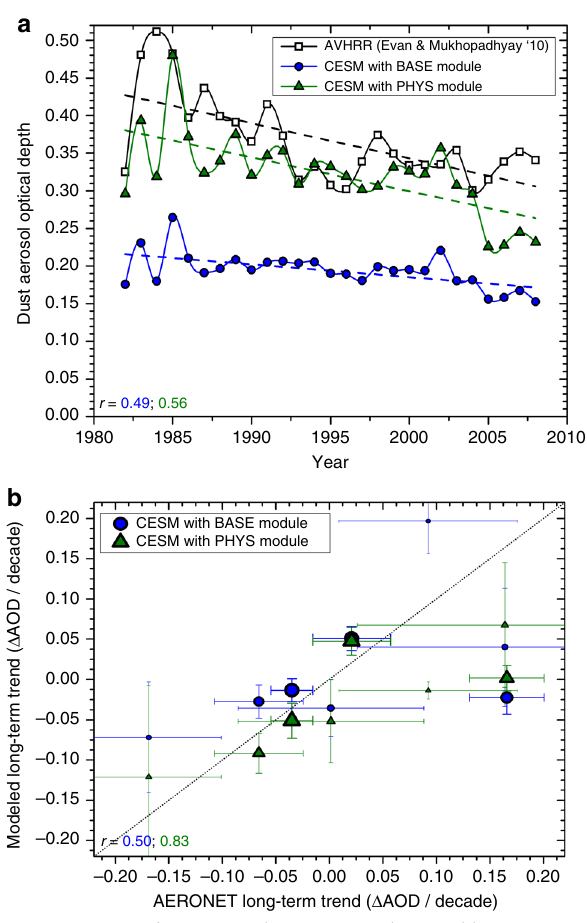
Fig. 1 Comparison of CESM simulations against historical long-term changes in dust aerosol optical depth. a Shown is the AVHRR satellite record of annually averaged dust AOD (black line and squares) over the dust-dominated region of 10 – 20°N and 20 – 30°W, off the West-African coast 27,32 . The CESM simulation with the BASE dust emission module (blue line and circles) poorly reproduces the magnitude and historical trend of the dust AOD, whereas CESM with the PHYS emission module (green line and triangles) better reproduces both the magnitude of the dust AOD and its long-term trend. The slope of the least-square linear fi t lines (dashed lines) are − 0.047 ± 0.011 per decade (corresponding to − 13 ± 3% per decade) for the AVHRR data, − 0.017 ± 0.005 per decade (corresponding to − 9 ± 2% per decade) for the BASE-AVHRR simulation, and − 0.045 ± 0.010 per decade (corresponding to − 14 ± 3% per decade) for the PHYS- AVHRR simulation. b Shown are the modeled long-term trends in AOD with the BASE and PHYS emission modules, compared against the measured trends at eight AERONET stations (see Supplementary Figs. 1 and 2 for results from the individual stations) for which these long-term changes are dominated by changes in dust aerosols (see Methods). The size of the symbols is proportional to the number of years of data for each station, and error bars were obtained from least-squares fi tting of the modeled annually averaged AOD at each site. For both panels, r denotes the Pearson correlation coef fi cients between the measured and modeled long-term trend in the annually averaged AOD